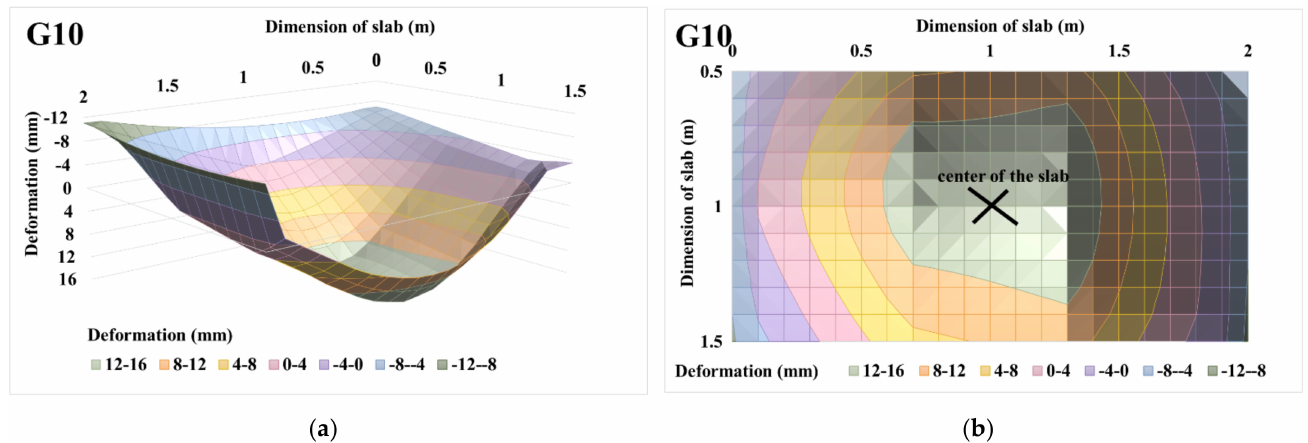
Figure 21. Centrically loaded slab G10 with 450 kN load: ( a ) 3D deformation surface of the slab; ( b ) projection of 3D deformation surface of the slab.